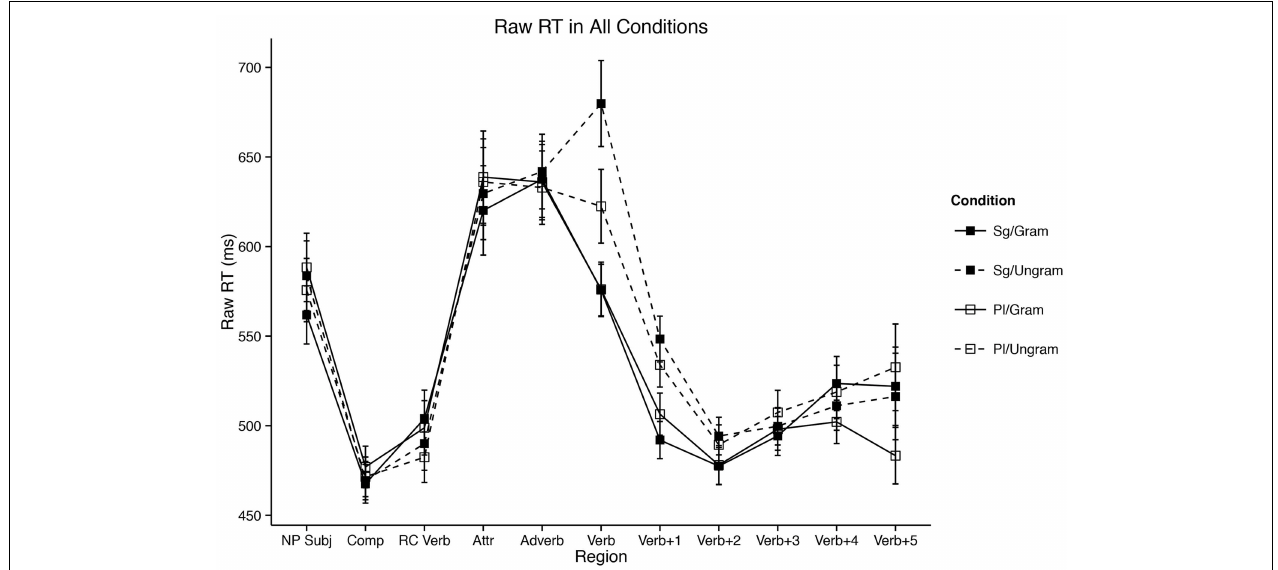
FIGURE 1 | Self-paced reading results. Region by region means segregated by attractor number and verb number. Error bars represent the standard error of the mean computed across subject averages.